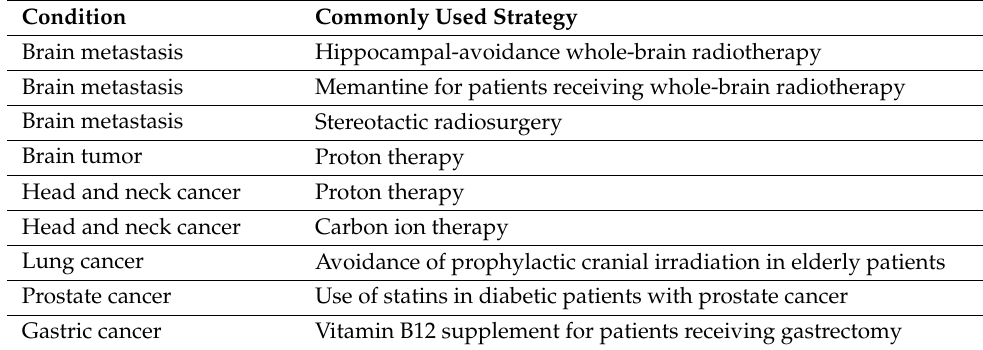
Table 1. Commonly used strategies to reduce dementia in cancer patients.